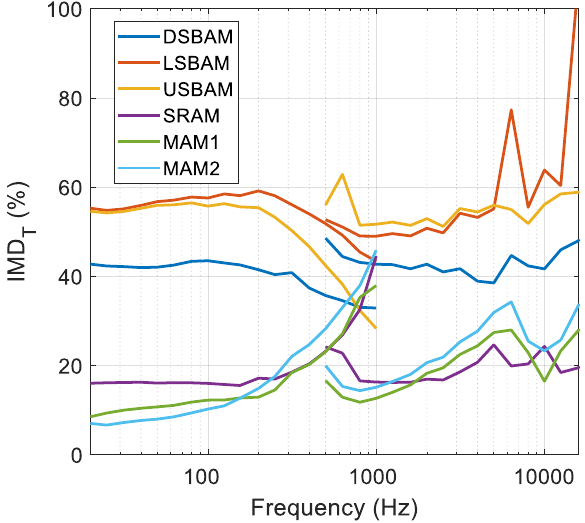
Figure 7. Comparison of IMD T values for each modulation (m = 1)